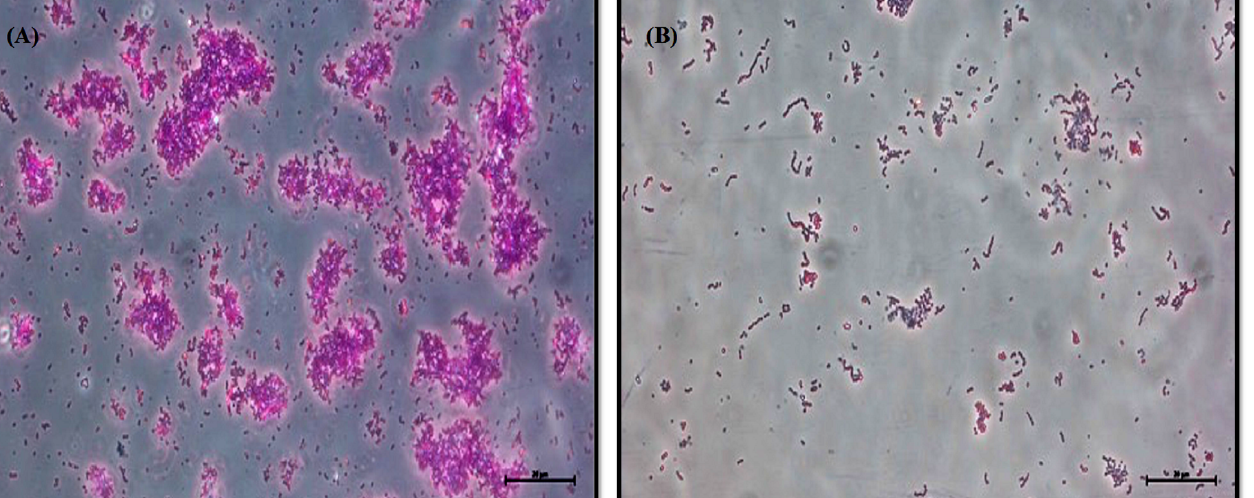
Figure 1. ( A ) Percent biofilm inhibition in S. pyogenes . The inhibition of biofilm formed by S. pyogenes in presence of LME at various concentrations. GC, growth control. *** p value = 0.0002, ** p value = 0.0042. ( B ) Growth curve dynamics. Figure represents the effect of LME (at BIC value) on the growth curve of S. pyogenes . * p value = 0.014.